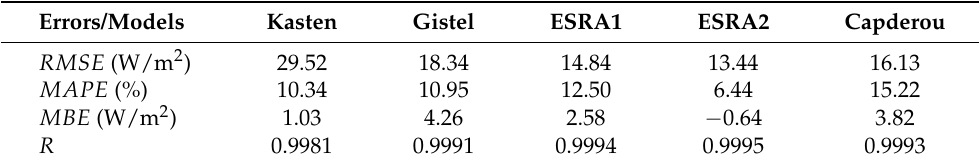
Table 1. Average errors in the estimation of the Linke turbidity. Errors/Models